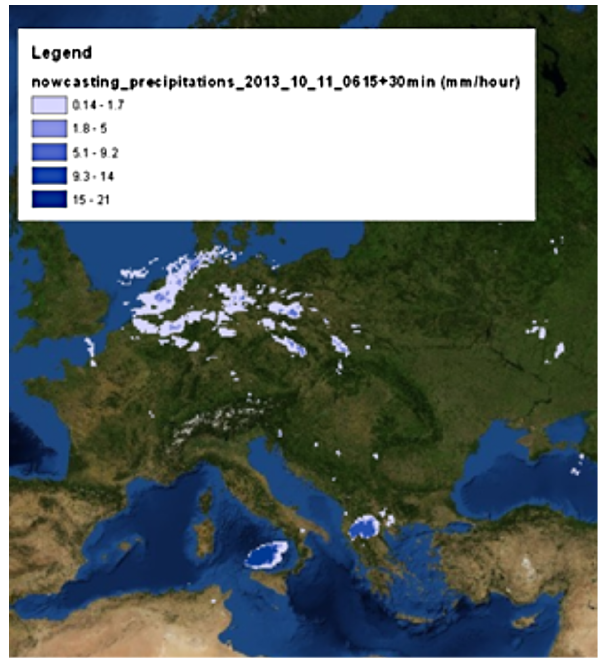
Figure 7. 30min precipitation forecast based on MPE of 11 Octo- ber 2013